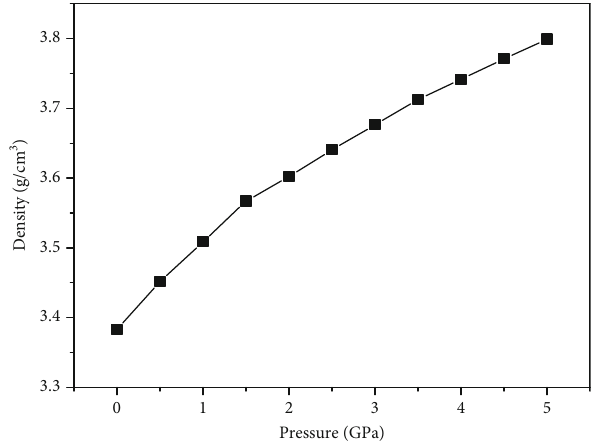
Figure 2: The density of orpiment As